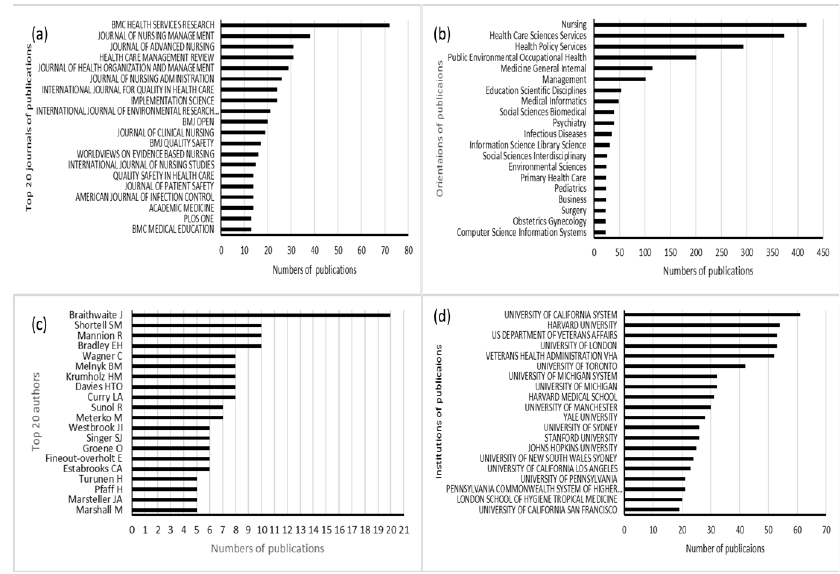
Figure 4. ( a ) The top 20 journals of publications; ( b ) The top 20 orientations of publications; ( c )